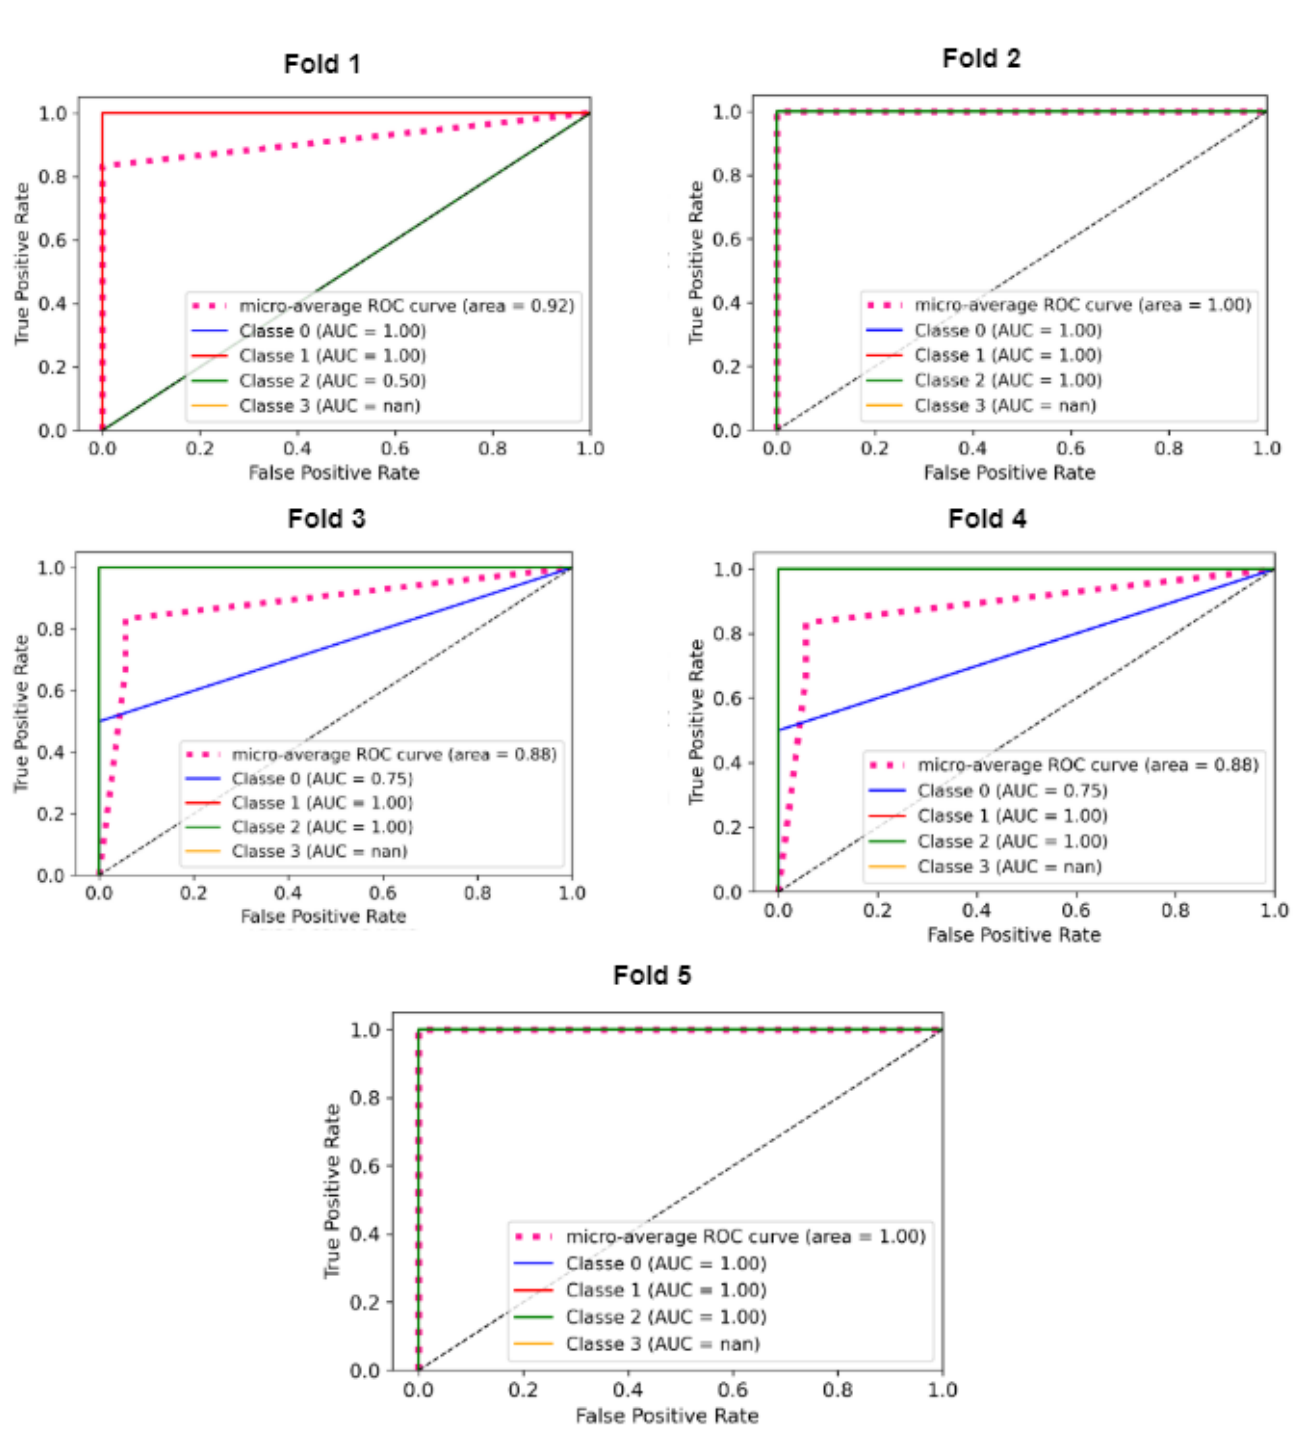
Figure 3. ROC curves of the DT model using SMOTE and the nested CV method for the five first folds. Each graphic represents one of the ten